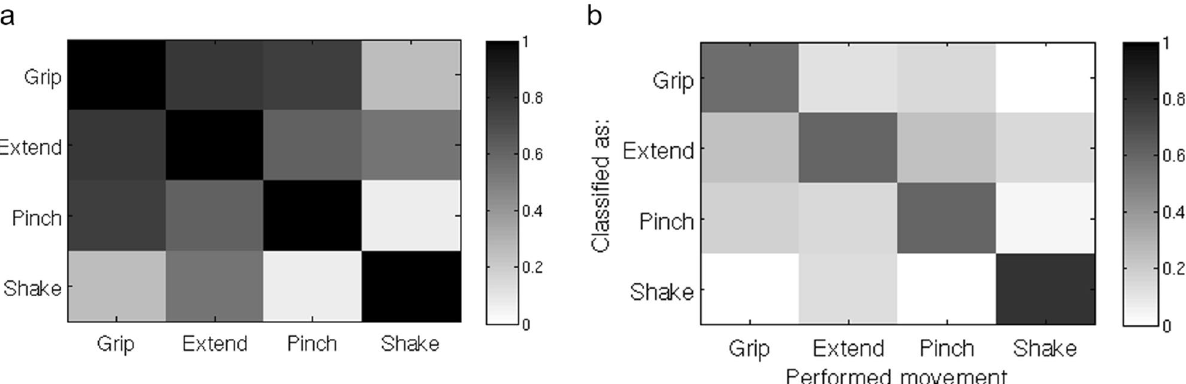
Figure 3. (a) Similarity matrix of task-defined patterns. Pearson correlation was used to estimate the similarity between the different patterns used in the main analysis. Similarity between the Grip, Extend, and Pinch patterns was higher than their similarity to the Shake pattern. the color scale represents the mean Pearson r values across all the participants. (b) Confusion matrix representing the mean correct classification rate of each movement pattern (diagonal) and the misclassification rate as a function of the incorrect response given by the classifier. The figure shows that the similar patterns (Grip, Extend, and Pinch) were misclassified as each other more often than they were misclassified as the Shake movement. The color scale represents the fraction of cases in which the tested pattern (x-axis—the performed movement) was classified as each of the four movements